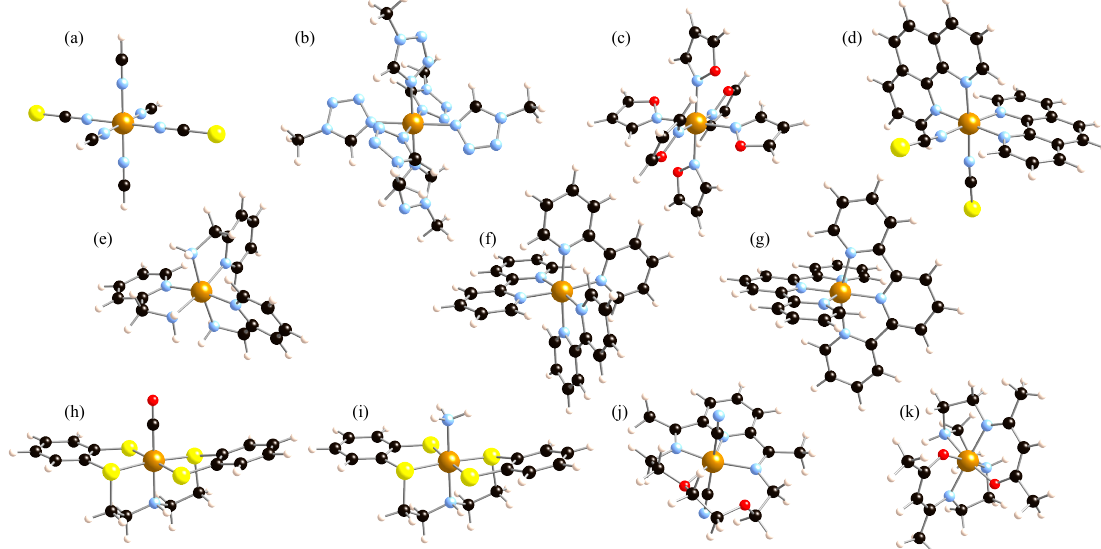
Figure 2. Molecular complexes investigated in this study: [Fe(NCS) 2 (NCH) 4 ] ( a ), [Fe(mtz) 6 ] 2 + ( b ), [Fe(iso) 6 ] 2 + ( c ), [Fe(phen) 2 (NCS) 2 ] ( d ), [Fe(pic) 3 ] 2 + ( e ), [Fe(bpy) 3 ] 2 + ( f ), [Fe(terpy) 2 ] 2 + ( g ), [Fe(CO)(N H S 4 )] ( h ), [Fe(NH 3 )(N H S 4 )] ( i ), [FeL(CN) 2 ] · H 2 O ( j ), and [Fe(acac) 2 trien] + ( k ). Fe is in the center of the complexes, represented by a light brown sphere. Black spheres represent C; blue is N; red is O; yellow is S; and pink is